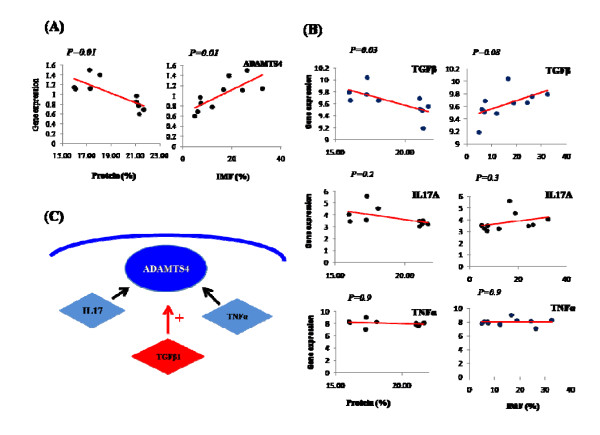
Gene expression analysis of selected genes in ADAMTS4 pathway: (A) gene expression for ADAMTS4 gene in muscle with divergent IMF and protein content. (B) gene expression for three stimulators (IL17, TNFα and TGFβ1) of ADAMTS4 protein in muscle with divergent IMF and protein content. (C) Co-expression of ADAMTS4 and TGFβ1.